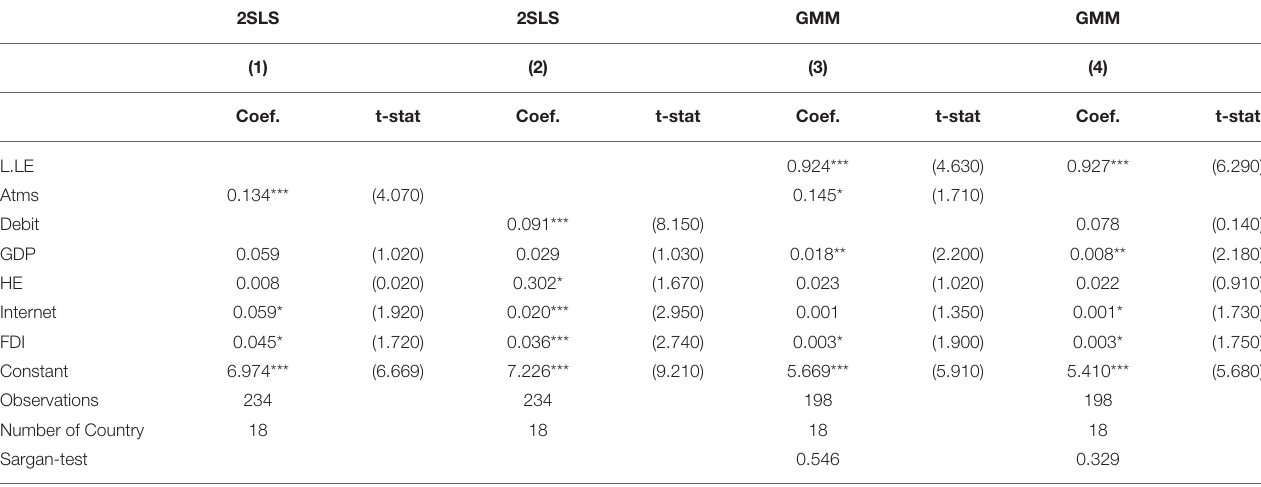
TABLE 3 | FinTech and life expectancy (2SLS and